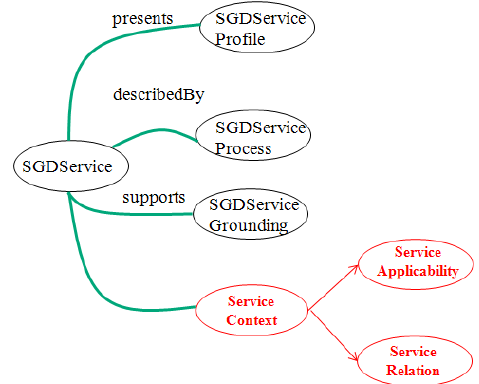
Fig.1. OWL-SC based service context description